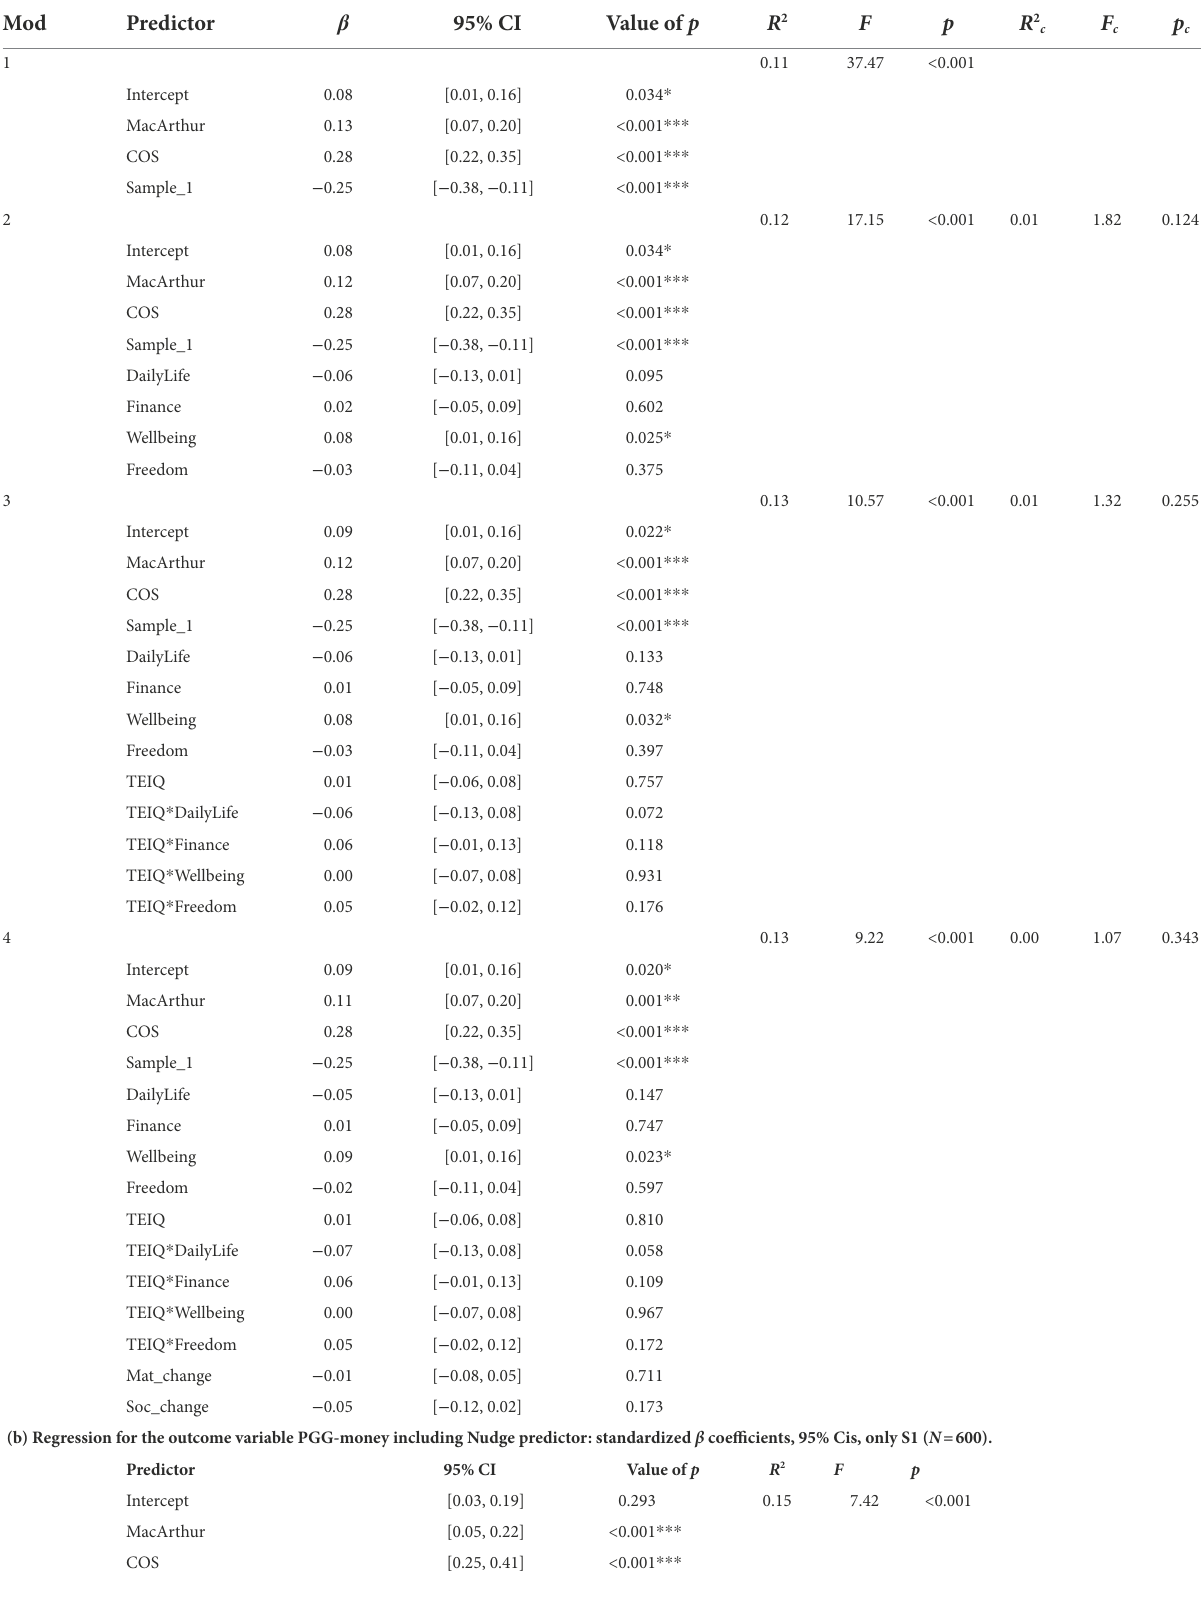
TABLE 3(a) Hierarchical regression for the outcome variable PGG-money: standardized β coefficients, 95% CIs and change statistics for four models ( N = 900). Mod Predictor β 95%